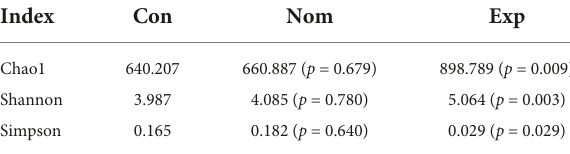
TABLE 2 Analysis of alpha diversity